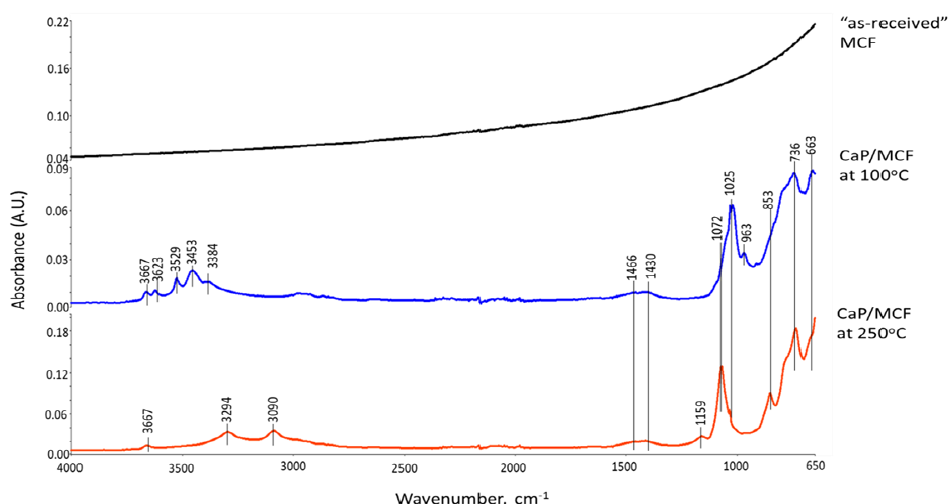
◦ C-autoclaved CaP/MCF cements.